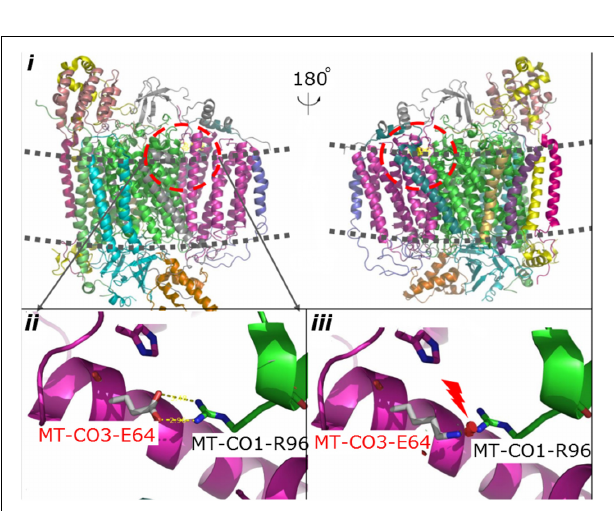
FIGURE 3 | Predicted structural model of MT-CO3. Image i is an overview of complex IV. Image ii shows the hydrogen bond between the WT glutamate at position 64 of MT-CO3 and an arginine in MT-CO1. Image iii shows the broken hydrogen bond caused by the change from glutamate to lysine at position 64 of